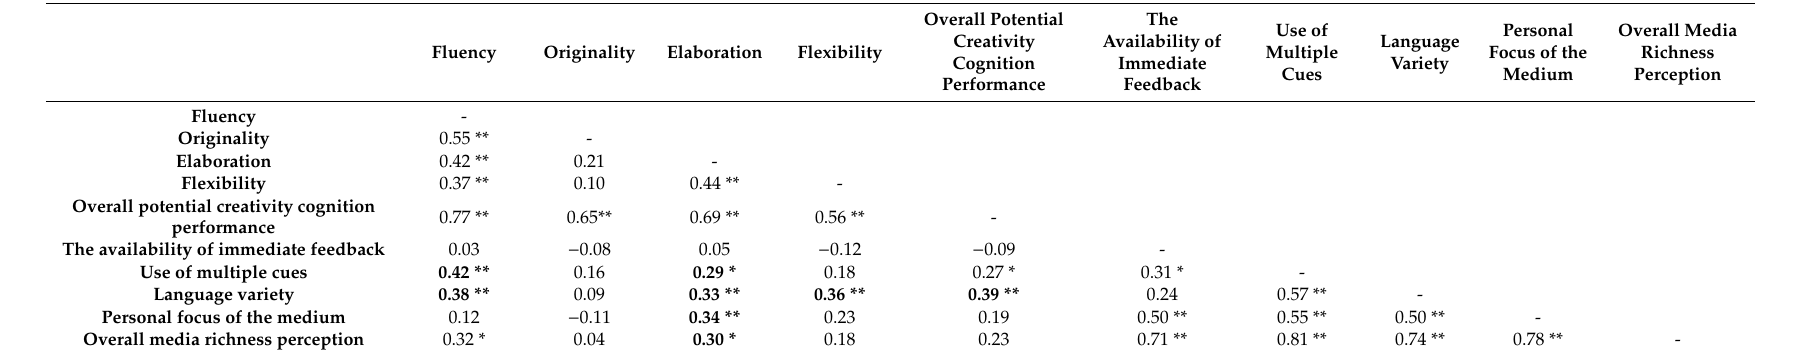
Table 11. Correlation between media richness perception and potential creativity cognition performance